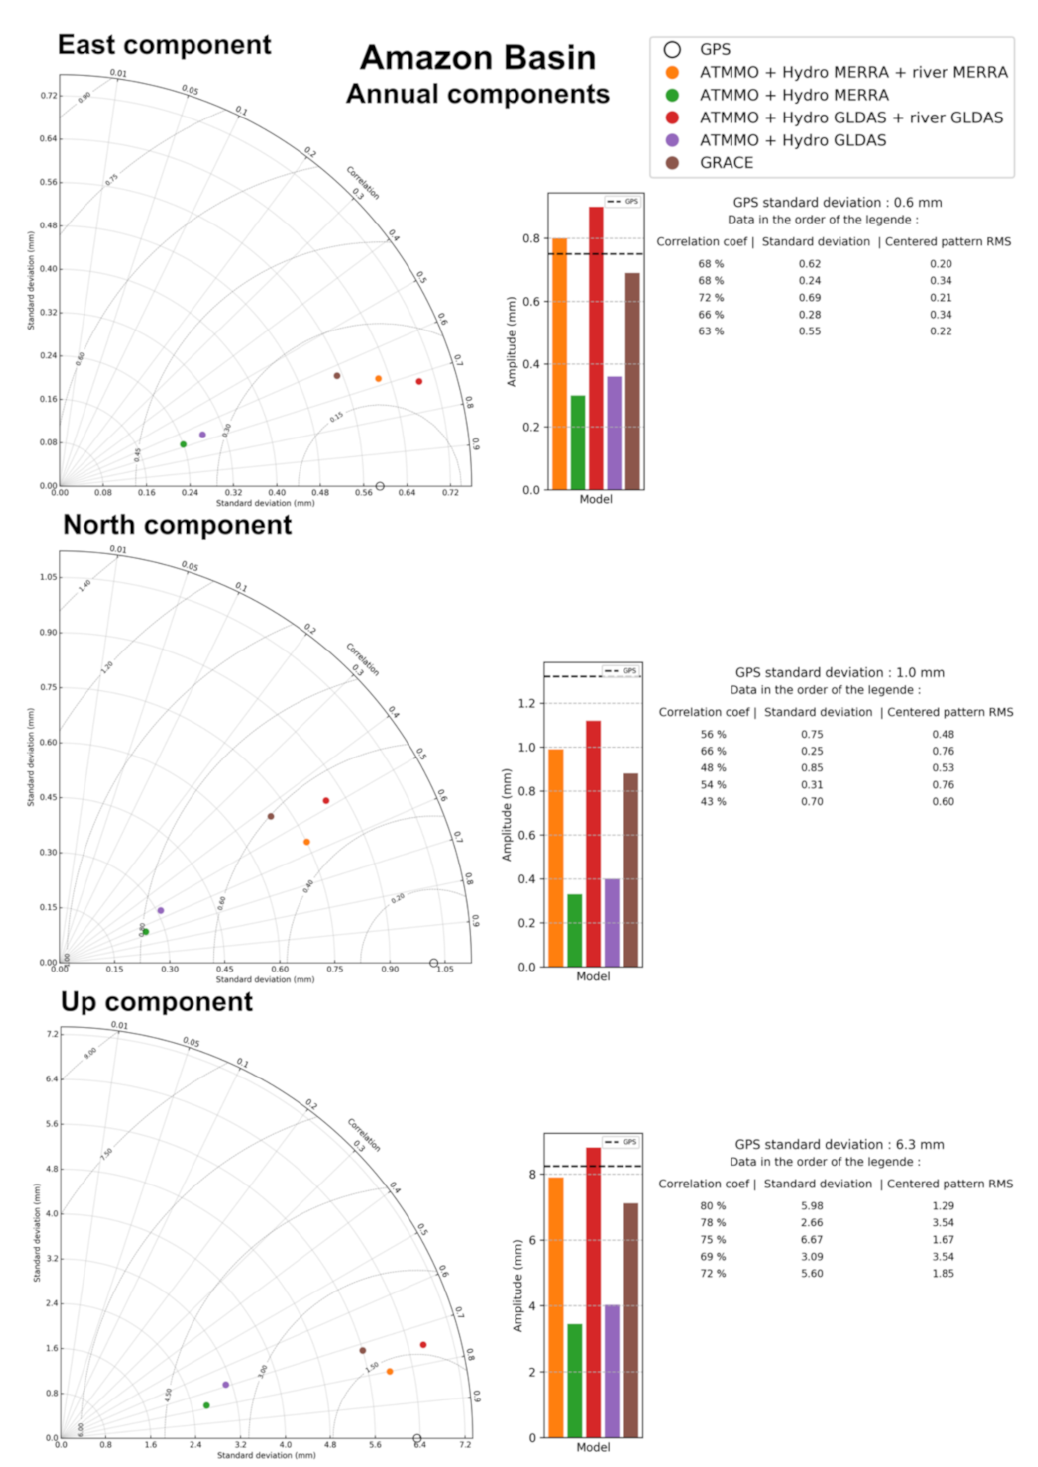
Figure 10. Taylor diagram for the annual term for the Amazon